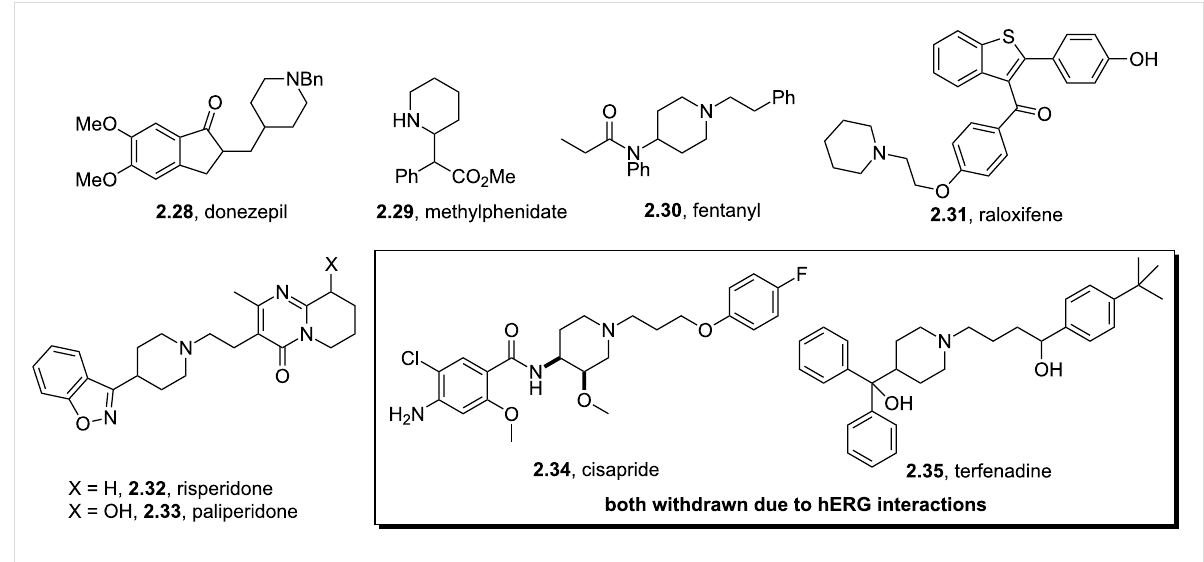
Figure 4: Examples of piperidine containing drugs.